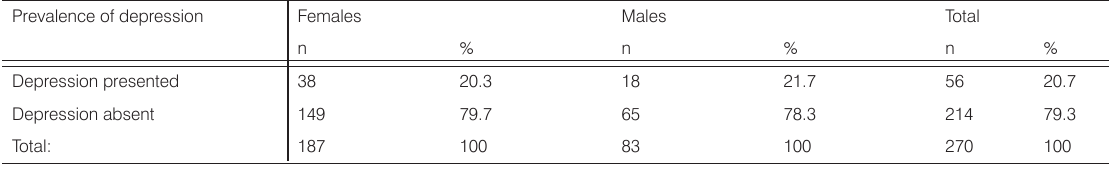
Table 1. Prevalence of depression in multiple sclerosis patients according gender.